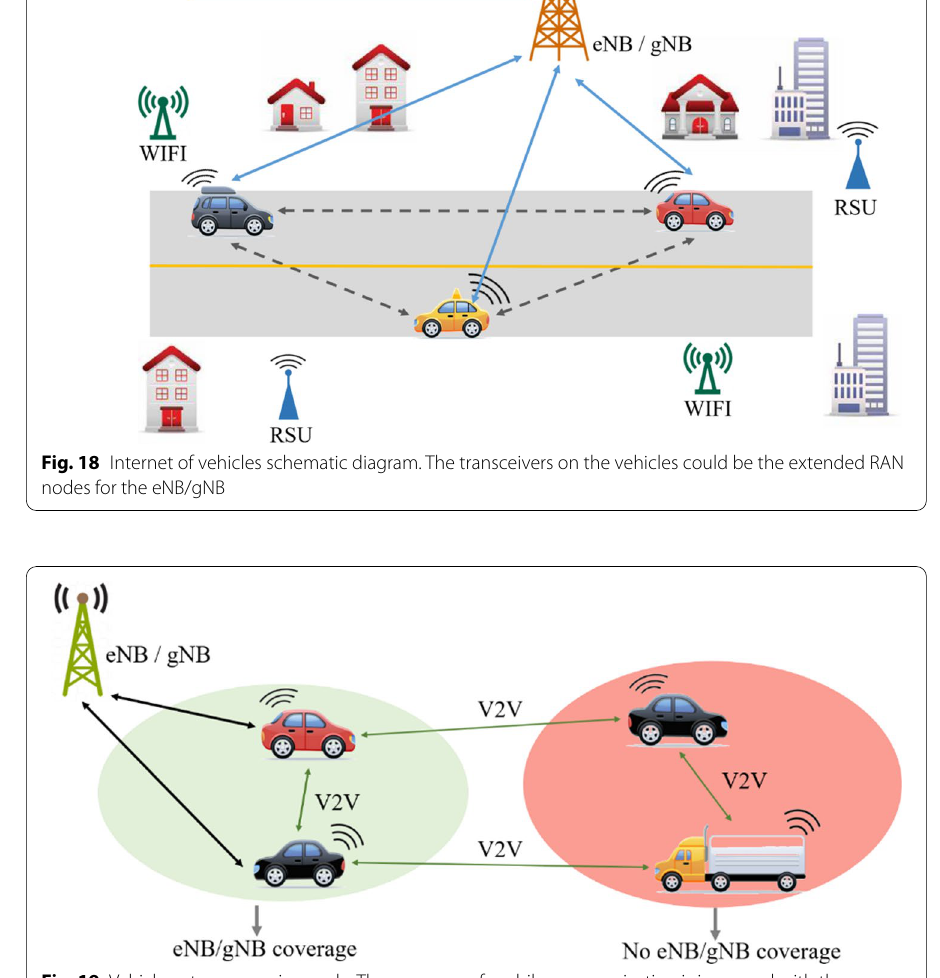
Fig. 19 Vehicle antenna as micronode. The coverage of mobile communication is improved with the automobile